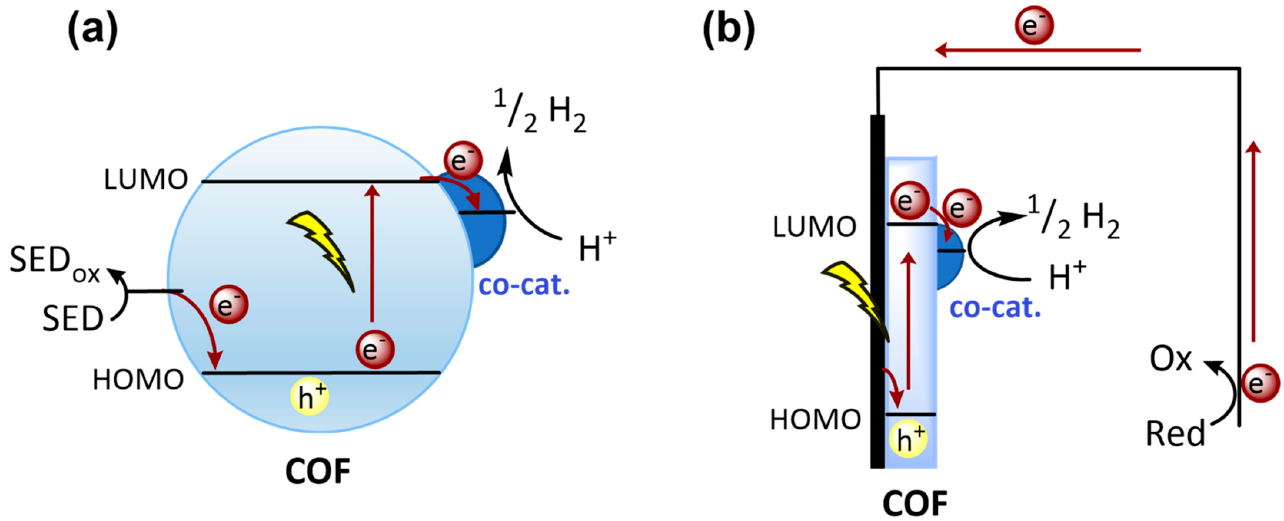
Figure 1. General overview of the photocatalytic HER mediated by COFs in a colloidal dispersion ( a ) and deposited onto an electrode ( b ).